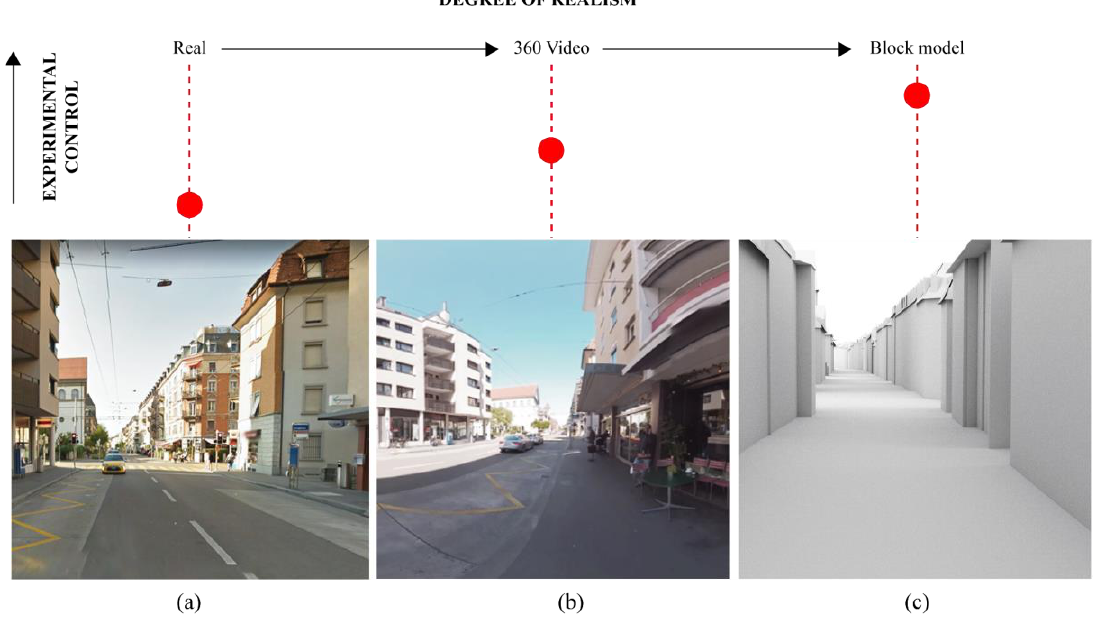
Figure 7. Three levels of abstraction: ( a ), ( b ), and ( c ) are example images of Zurich, Switzerland in the three abstraction levels. experimental framework (field study, 360° video and geometry model) that enhances experimental control in each setting.